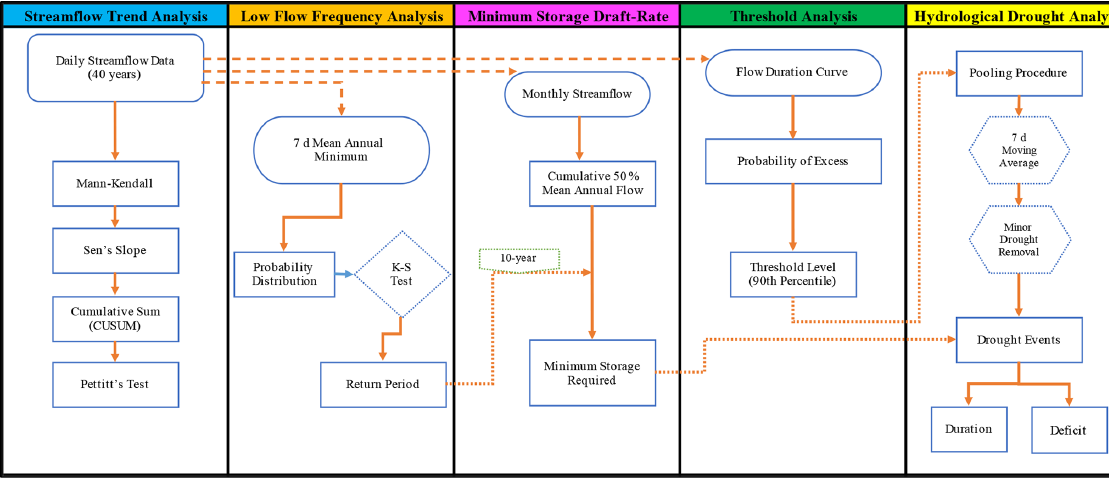
Figure 2. Summary of the methodological